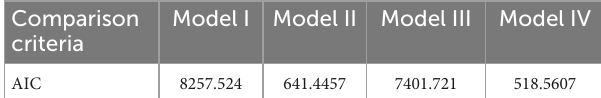
TABLE 4 Model comparison and